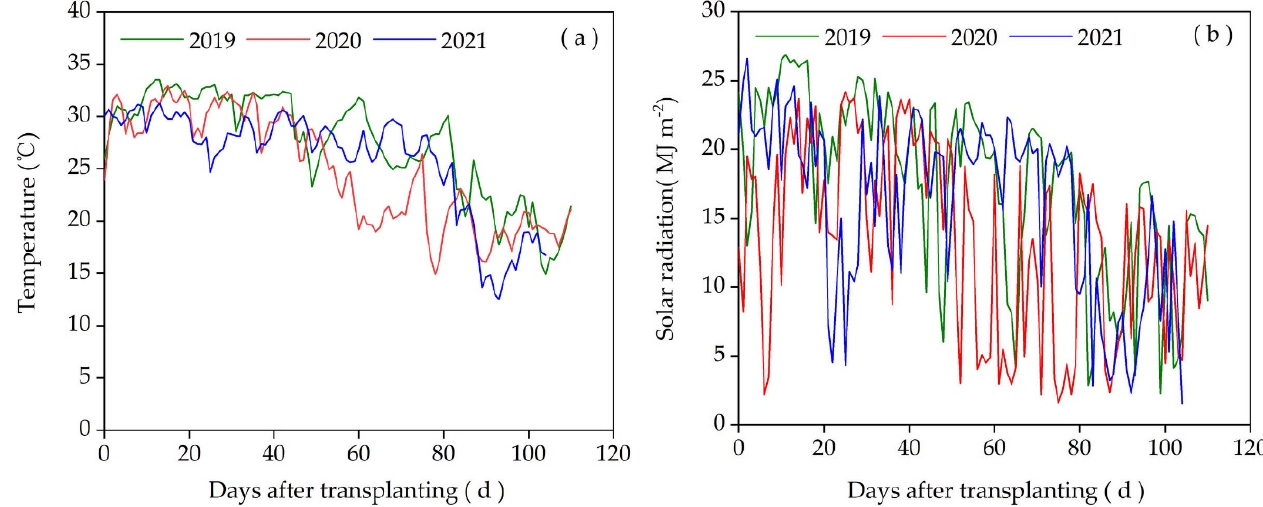
Figure 1. Daily mean temperature ( a ); and solar radiation ( b ) in 2019, 2020, and 2021.